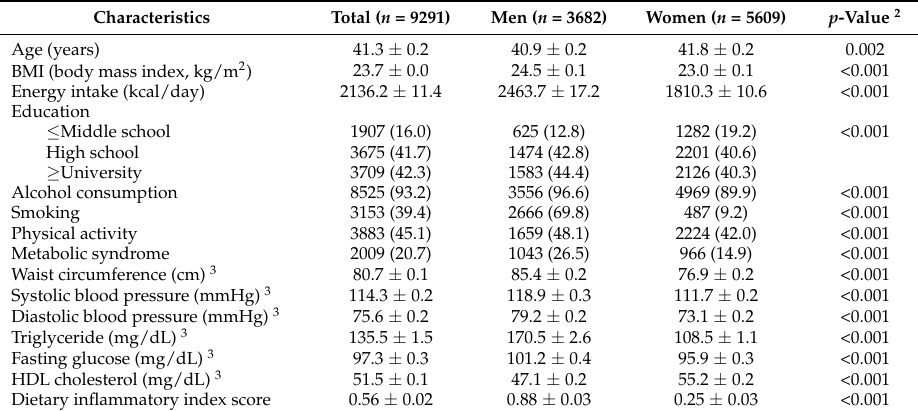
Table 1. General characteristics of the subjects.